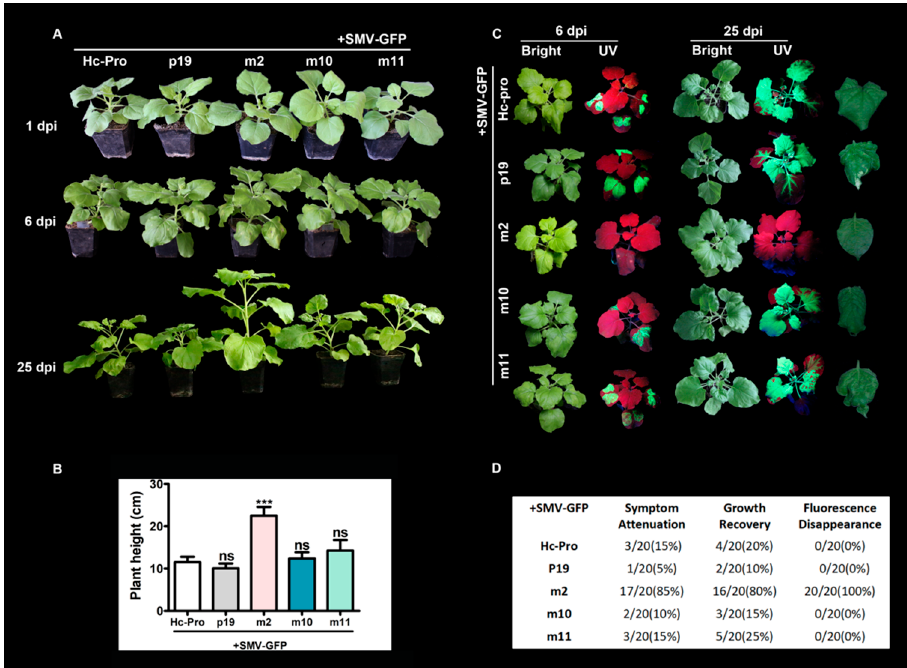
Figure 8. Effects of co-expression of Hc-Pro mutants on SMV-GFP infection. ( A ) Plant phenotypes at different days upon co-expression of Hc-Pro mutants and SMV-GFP infection. ( B ) Plant height. T-test was performed between treatment and control group. Triple asterisks, p < 0.001. ns, non-significant. ( C ) GFP fluorescence visualized under UV light. Representative leaves under bright light are shown on the right panel. ( D ) Symptom statistics.